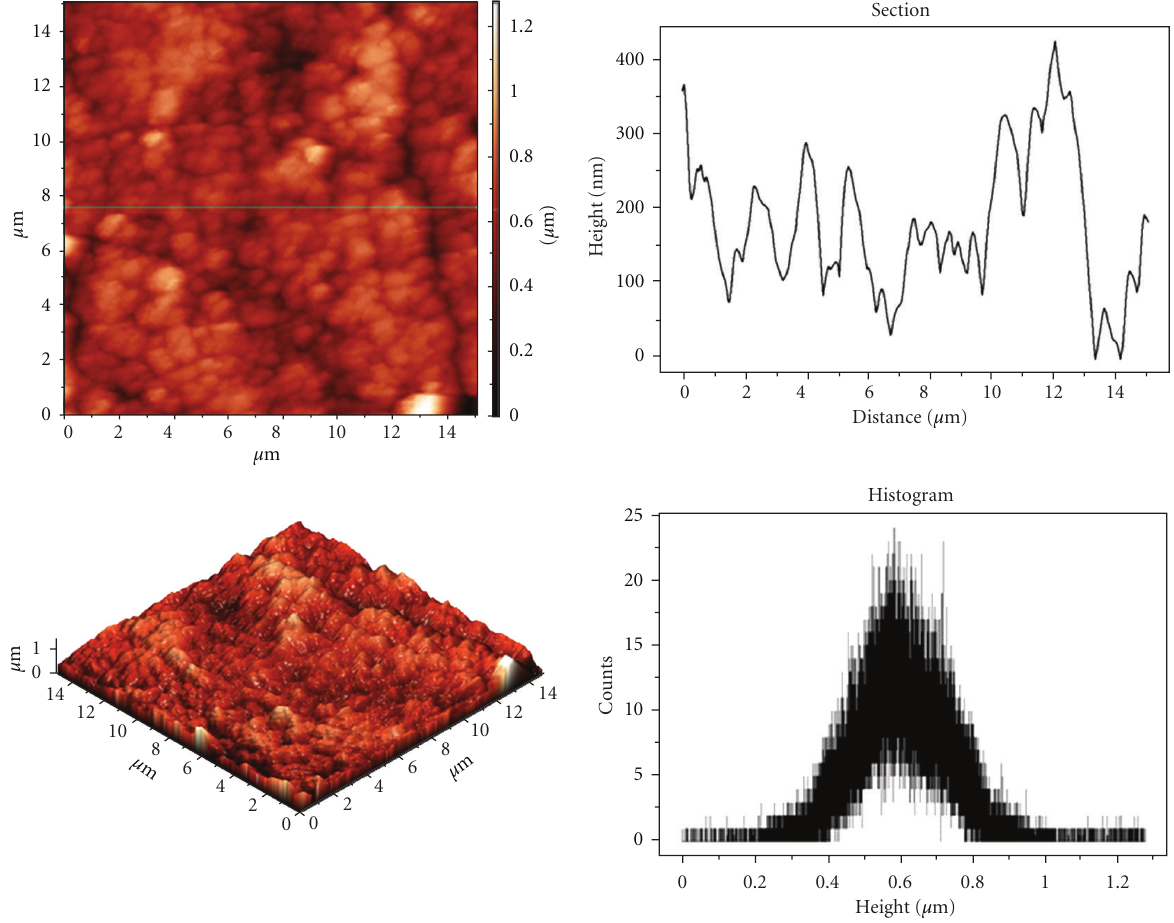
Figure 8: AFM images (2D and 3D) and the section profile of the thin layer of poly(AnPS- co -An) deposited on the Pt electrode surface by cyclic